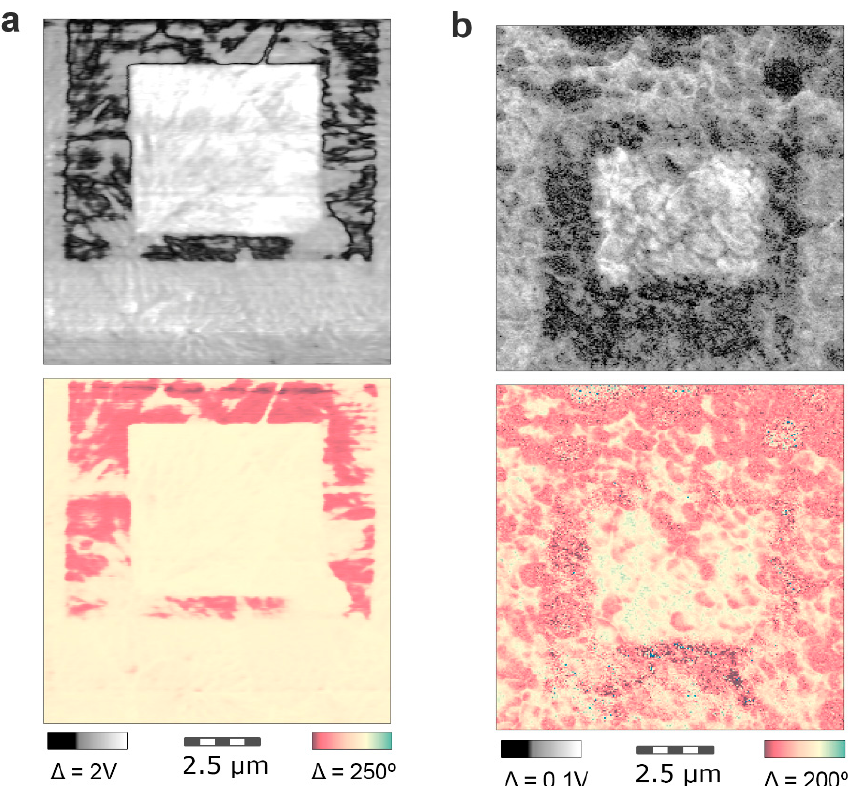
Figure 6. ( a ) PFM amplitude (top) and phase (bottom) of the PVDF ‐ 20 film 24 h after the polariza ‐ tion process and image scanning; ( b ) PFM amplitude (top) and phase (bottom) of the F ‐ PVDF film 24 h after the polarization process and image scanning.